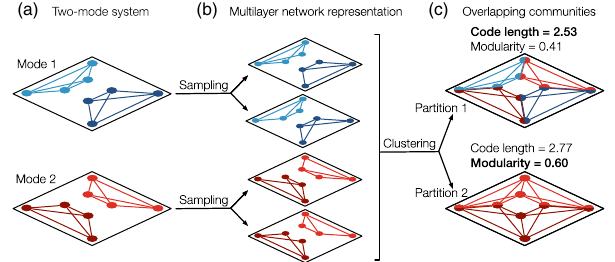
FIG. 2. Overlapping communities in multilayer benchmark networks. We generate the multilayer networks in two